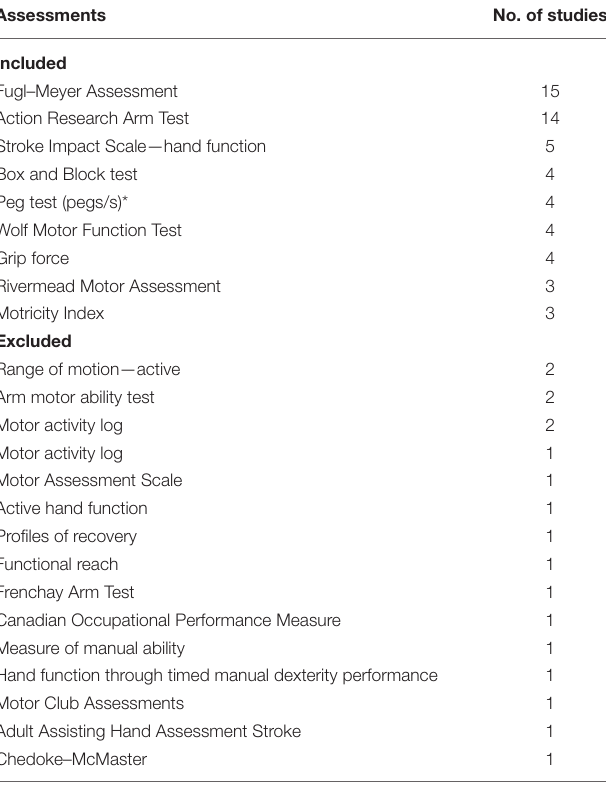
TABLE 2 | Frequency overview of the number of studies applying the assessment during at least one time point. Assessments No. of